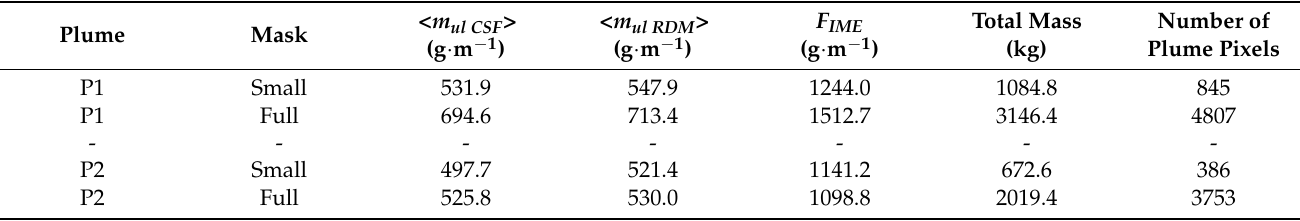
Table 5. Estimation of the wind normalized source flow rate corresponding to plumes P1 and P2 using LM retrieved concentration and CSF, RDM or IME flow rate estimation methods.